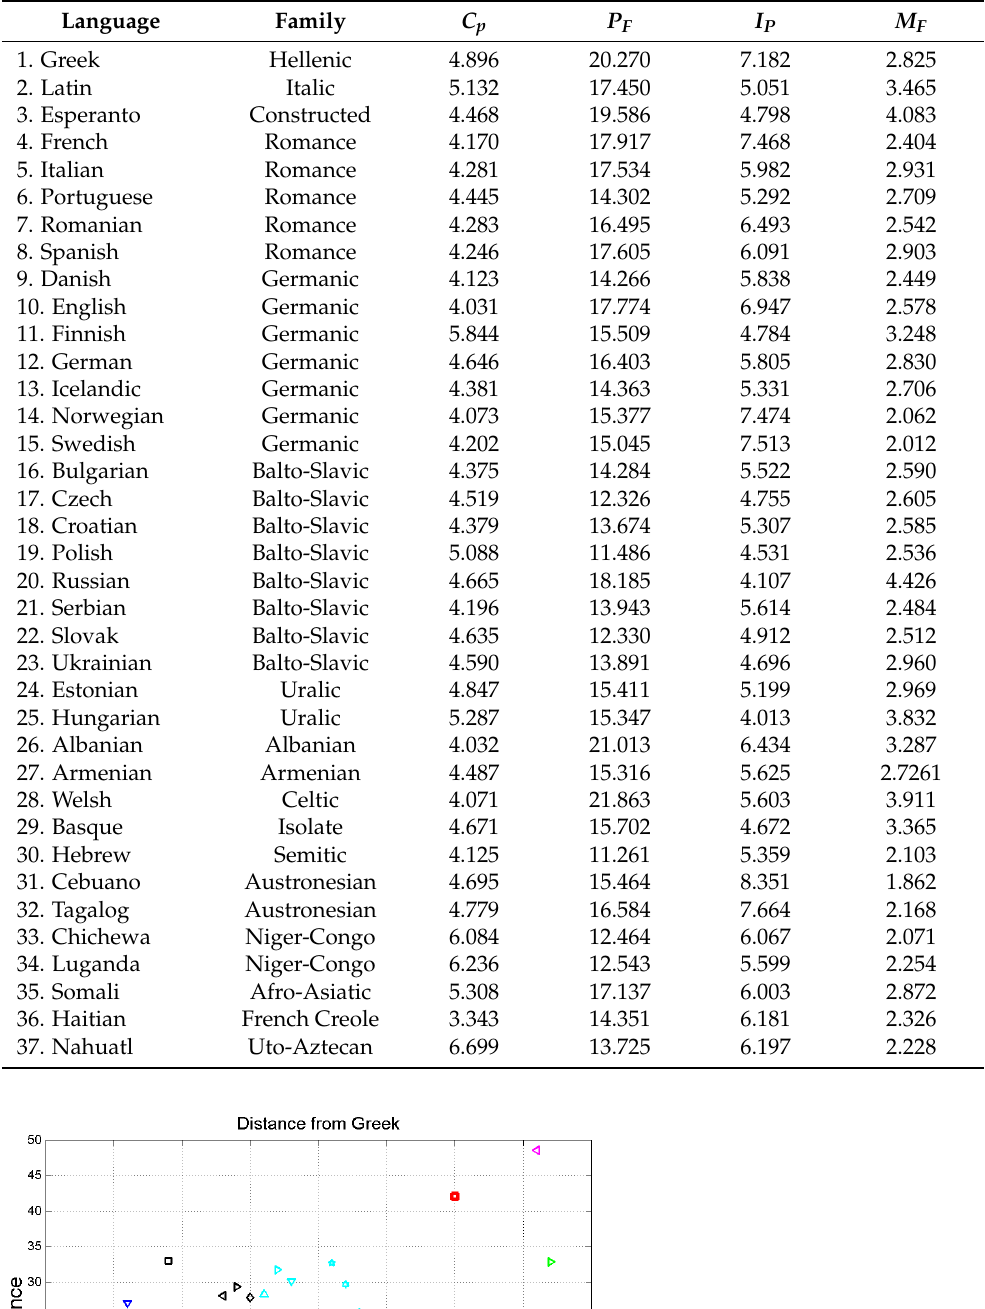
Table 1. Average values of C P (characters per word), P F (words per sentence), I P (words per inter- punction), M F (interpunctions, or number of I P , per sentence) in Matthew, in the indicated languages.